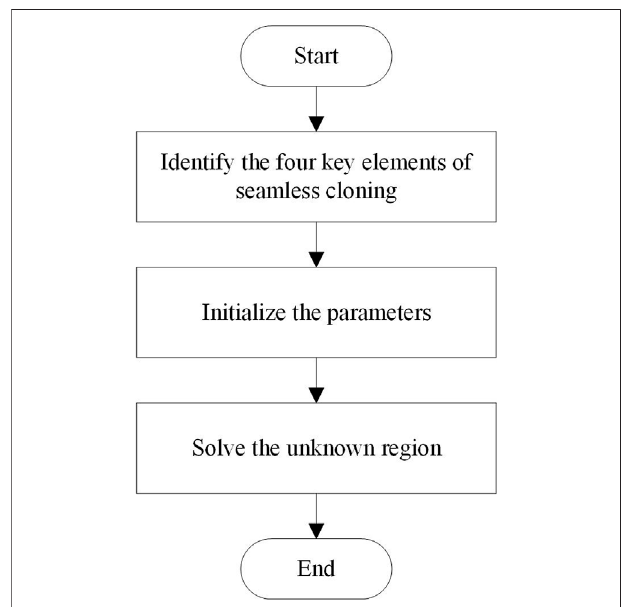
FIGURE 2 | Process of seamless cloning